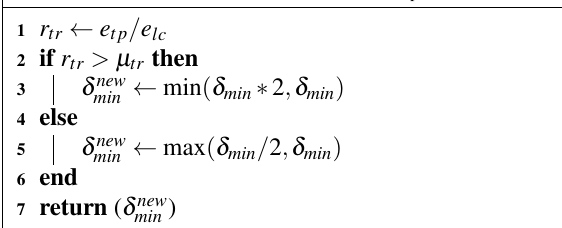
(cid:2) s ) Algorithm 6: readjustResolution( e tr ,